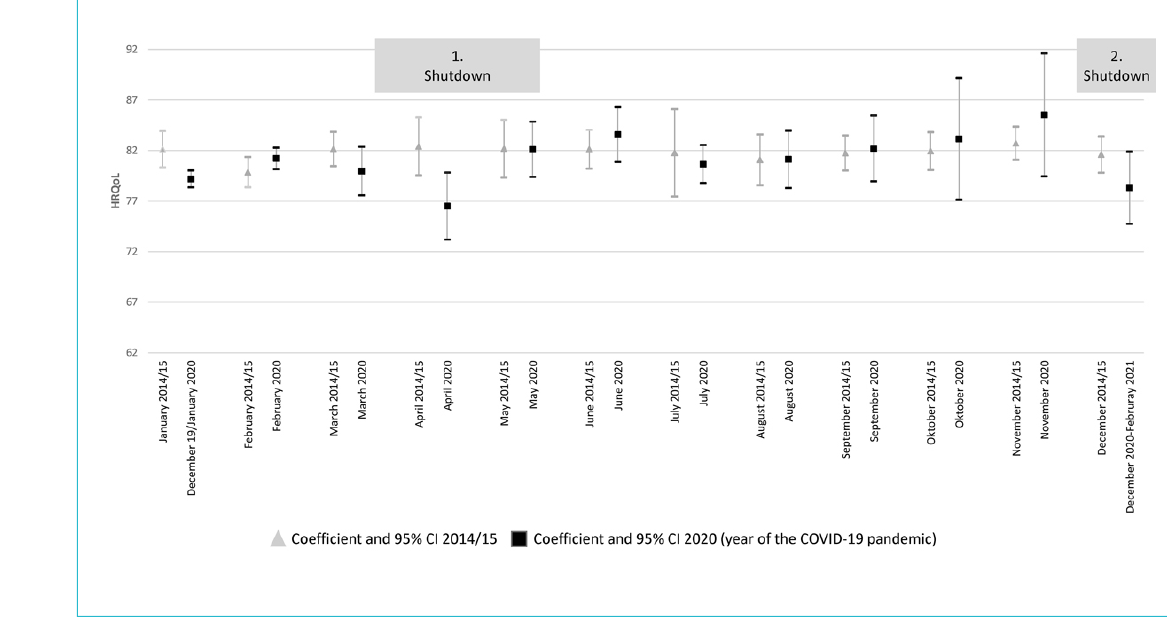
Figure 2: Adjusted a monthly means of health-related quality of life, by survey year. a Multivariate linear regression models adjusted for all characteristics which showed a significant association with health-related quality of life (supplementary Table1): age, sex, income, language region and urbanicity. Lockdown one, during the first COVID wave from 16 th March 2020 to 11 th May 2020. The lockdown included the closure of schools, shops (except groceries and pharmacies), sports and cultural facilities, hospitality, and zoos. Lockdown two, during the second COVID wave from December 2020 to the end of the data collection in February 2021. The lockdown included the closure of sports and cultural facilities, hospitality and zoos and limits for group sizes (e.g. a maximum of 5 people for sport during leisure time or 10 people at Christmas). Schools remained open. The axis scale was based on the span of the interquartile ranges for the